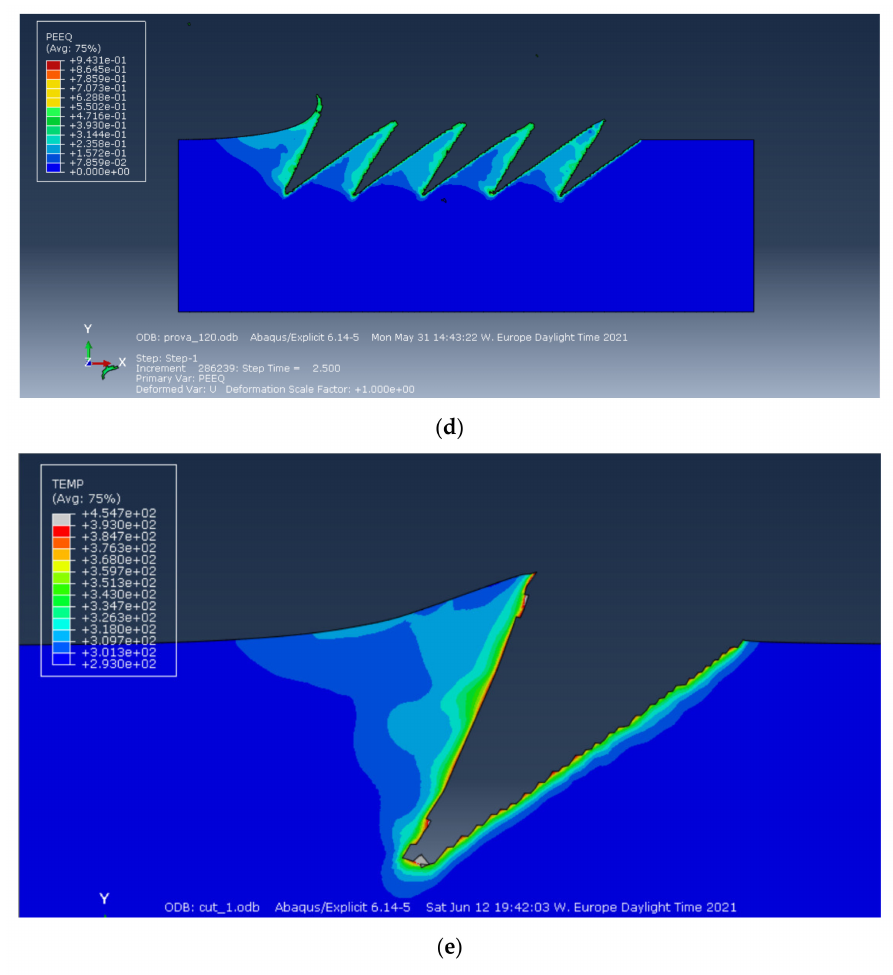
Figure 8. (a) Equivalent plastic strain for a single first cut in aluminum. ( b ) Equivalent plastic strain for spacing of 72 µ m in Abaqus in aluminum. ( c ) Equivalent plastic strain for spacing of 100 µ m in Abaqus in aluminum. ( d ) Equivalent plastic strain for spacing of 120 µ m in Abaqus in aluminum. ( e ) Temperature after one cut (in Kelvin) in